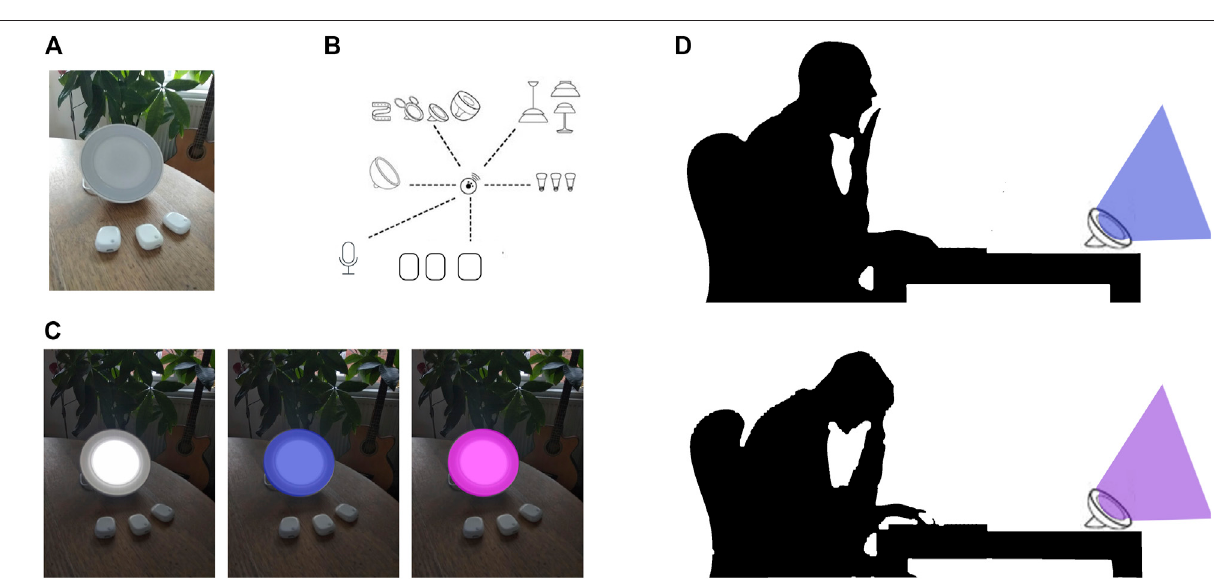
FIGURE 11 | Re fl ex-light: mood predictive architecture.